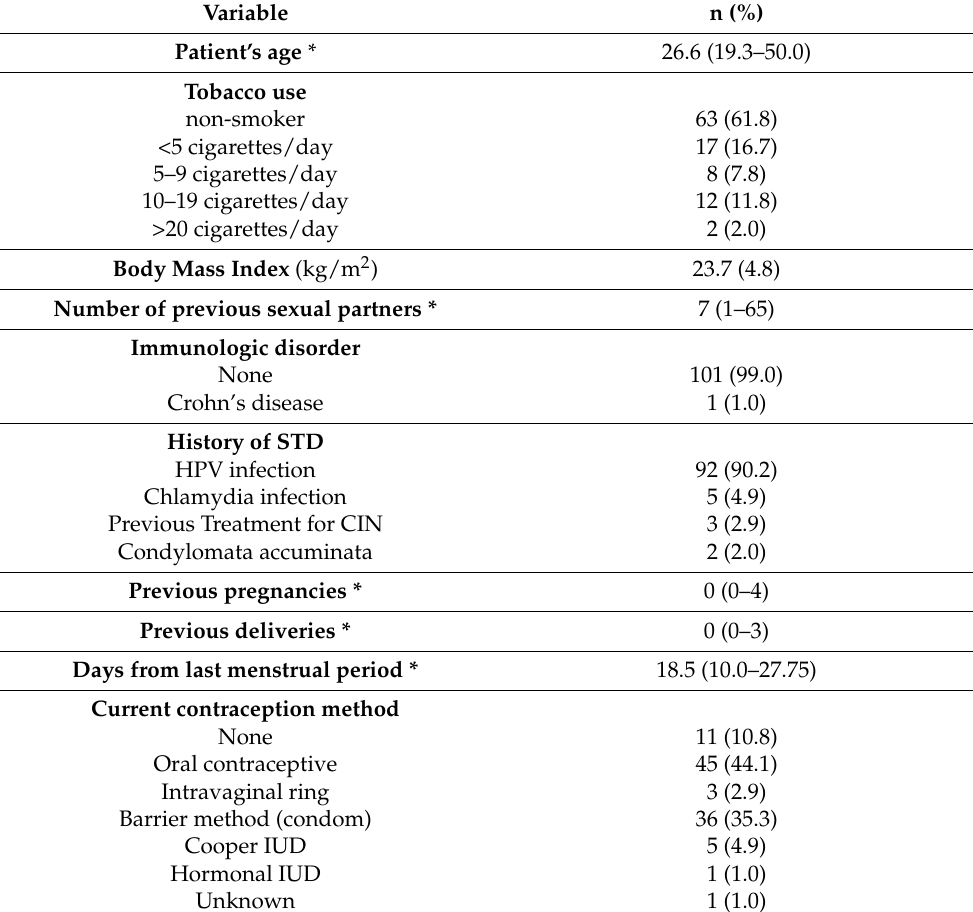
Table 1. Demographics of 102 patients with cervical intraepithelial neoplasia undergoing treatment with 85% trichloroacetic acid.